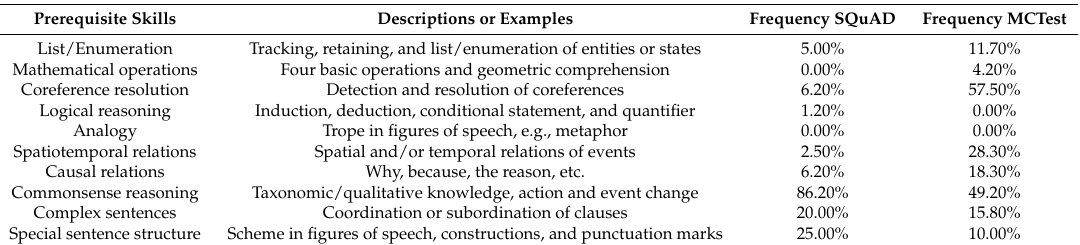
Table 8. Prerequisite skills with descriptions or examples [90], and their frequencies (in percentage)